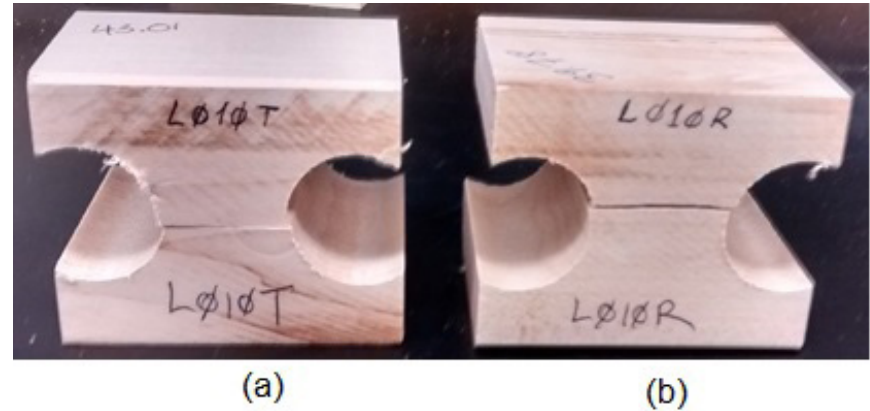
Figure 17. Typical failure mode in tangential and radial specimens in tension perpendicular to grain tests.